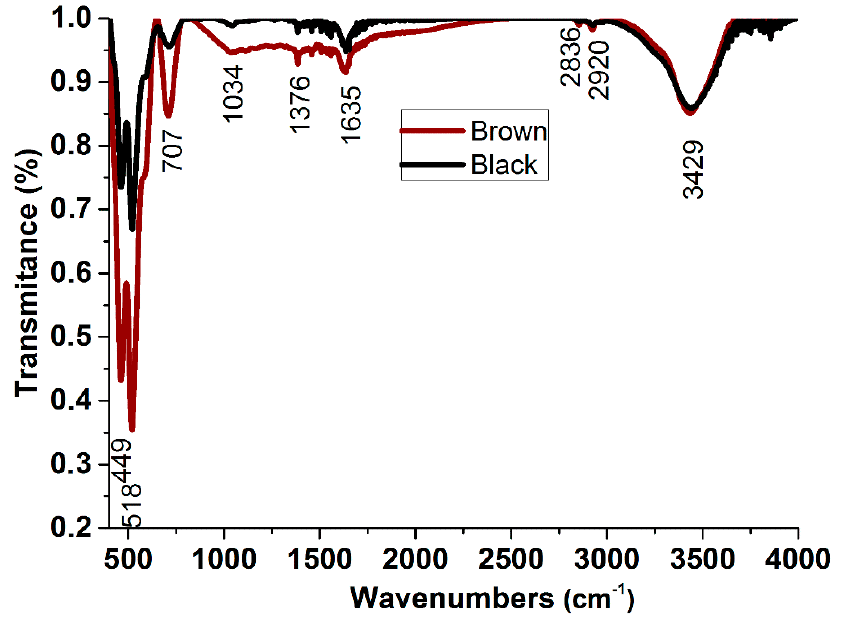
Figure 2. The FT-IR spectrum of the α -MnO 2 type manganese oxide was synthesized using the hydrothermal method.